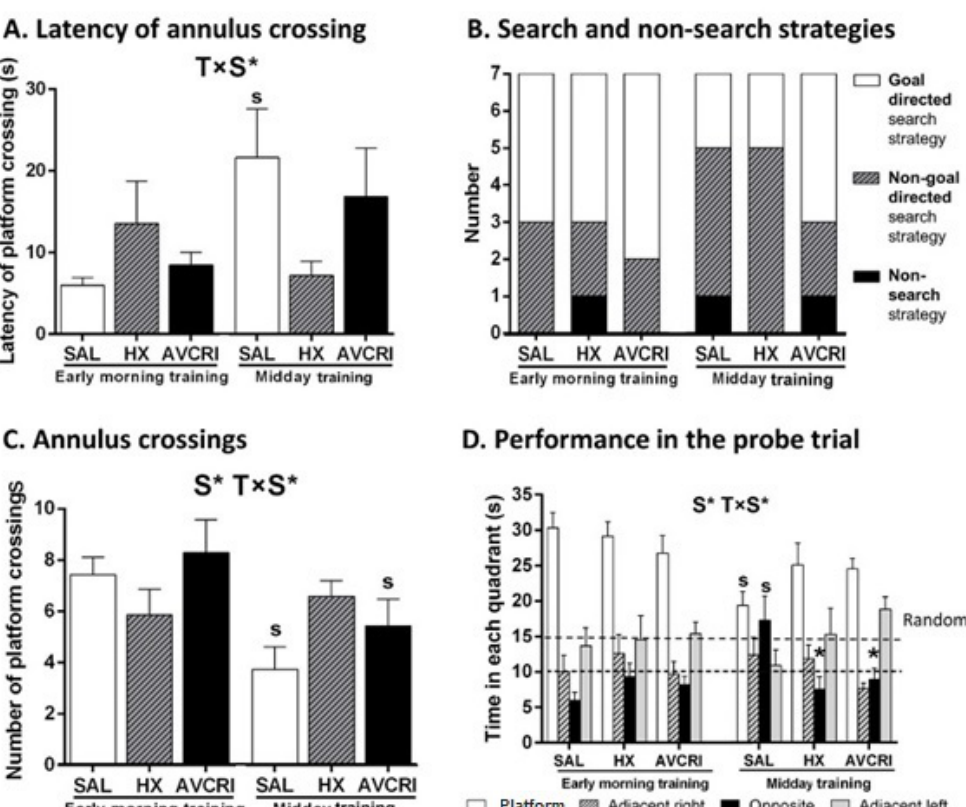
Figure 2. Effects of HX and AVCRIP104P3 on cognitive performance of 3xTg-AD mice in the probe trial for short-term memory in the early morning and midday training schedules. Results are expressed as mean ± SEM ( n = 7 in each group). ( A ) Latency of platform crossing (s), ( B ) qualitative analysis of search strategies (goal-directed and non-goal directed) and non-search strategies (floating and circling) employed until the achievement of the first annulus crossing, ( C ) annulus crossings, ( D ) time spent in each of the quadrants during the free swim trial: Platform, the trained quadrant where the platform was previously located, adjacent right, opposite and adjacent left quadrants. Time in random preference is indicated with dashed lines. Statistics: Split plot ANOVA: S ‘schedule’ effect, T × S ‘treatment × schedule’ interaction effects, * p < 0.05 with post hoc Bonferroni: * p < 0.05 vs. the same schedule saline group, s p < 0.05 vs. the same treatment early morning training group.